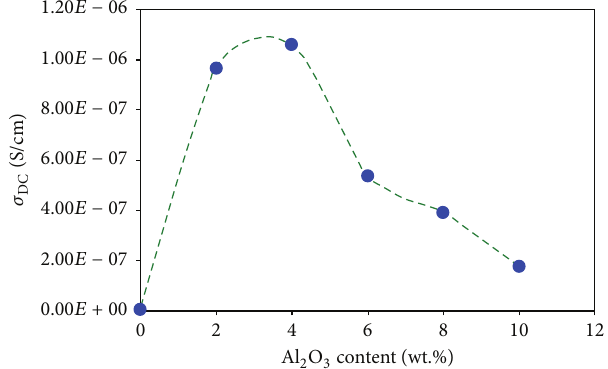
Figure 7: The ionic conductivity of chitosan : LiTf (CSC6) with various concentrations of Al 2 O 3 .